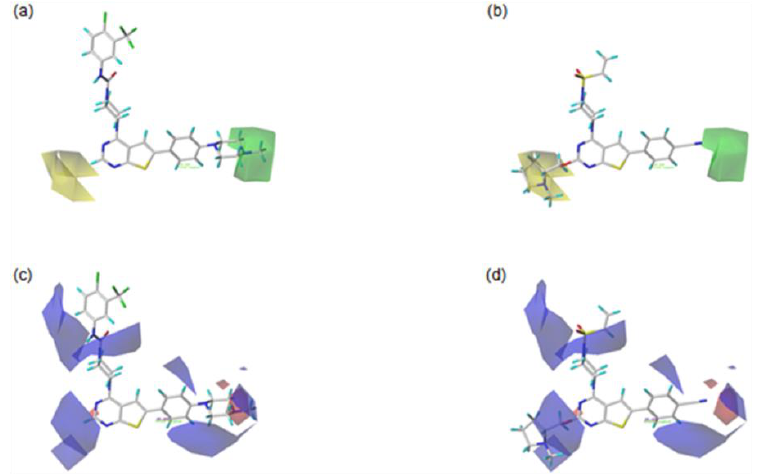
Figure 3. Contour maps of CoMFA analysis with the most active compound 42 ( left ) and the least compound 20 ( right ). In each field, favored and disfavored areas are fixed with 80% and 20% contribution levels, respectively; ( a , b ) Steric field: favored regions are in green contours and disfavored regions are in yellow contours; ( c , d ) Electrostatic field: favored regions are in blue contours and disfavored regions are in red contours.